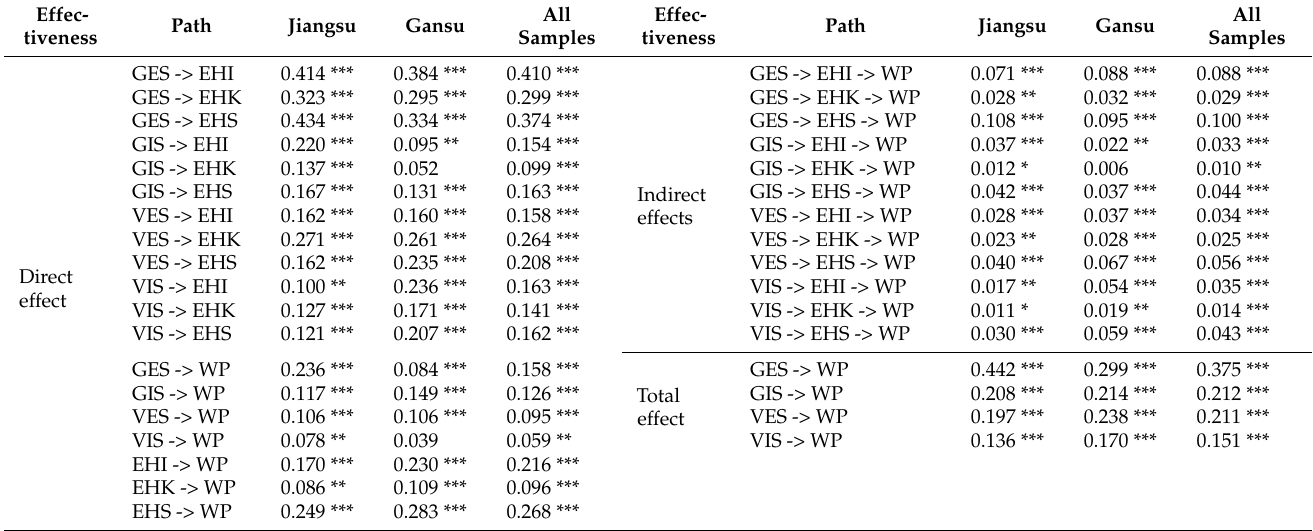
Table 7. Estimation results of the impacts of organizational support and environmental health literacy on farmers’ willingness to participate in rural living environment